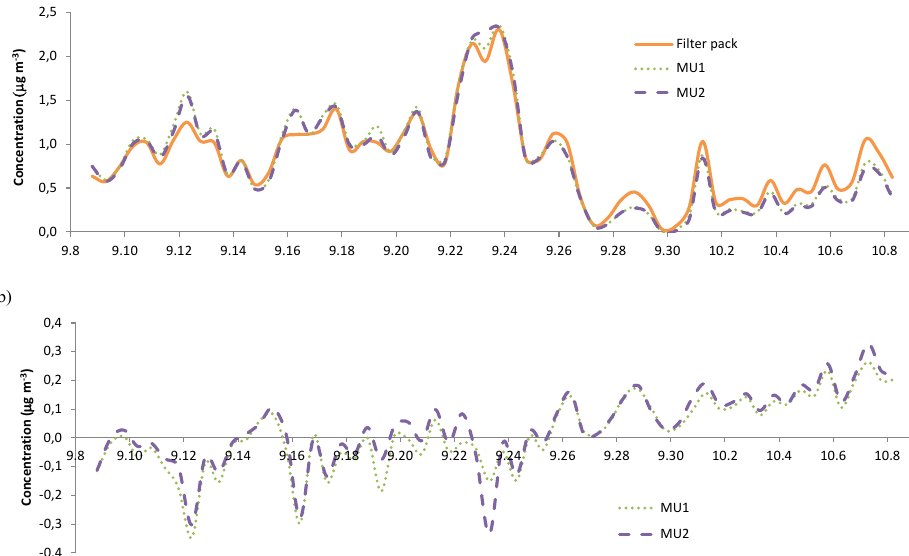
Figure 16. (a) NH + concentration trends for the MUs (unadjusted for the external standard) and the filter pack during the ETV period. 4 (b) Concentration difference (filter pack minus MUs) between the filter pack and the MUs NH +